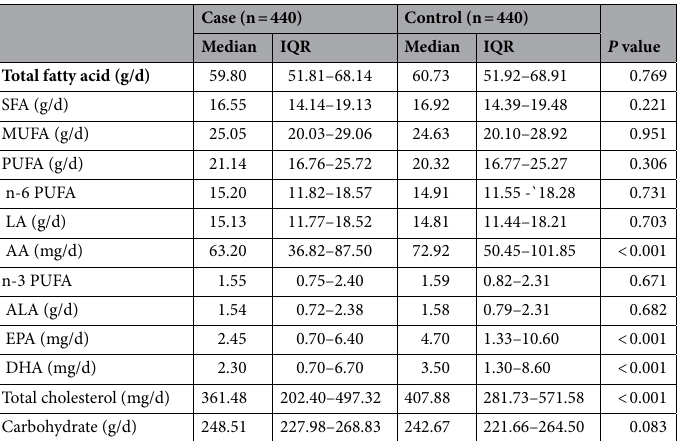
Table 2. Daily intake of dietary nutrients after energy-adjusted among preeclampsia cases and controls. Abbreviation: IQR: interquartile range; SFA, saturated fatty acids; MUFA, mono-unsaturated fatty acids; PUFA, polyunsaturated fatty acids; LA, linoleic acid; AA, arachidonic acid; ALA, alpha-linolenic acid; EPA, eicosapentaenoic acid; DHA, docosahexaenoic acid. Median values and 25 th , 75 th